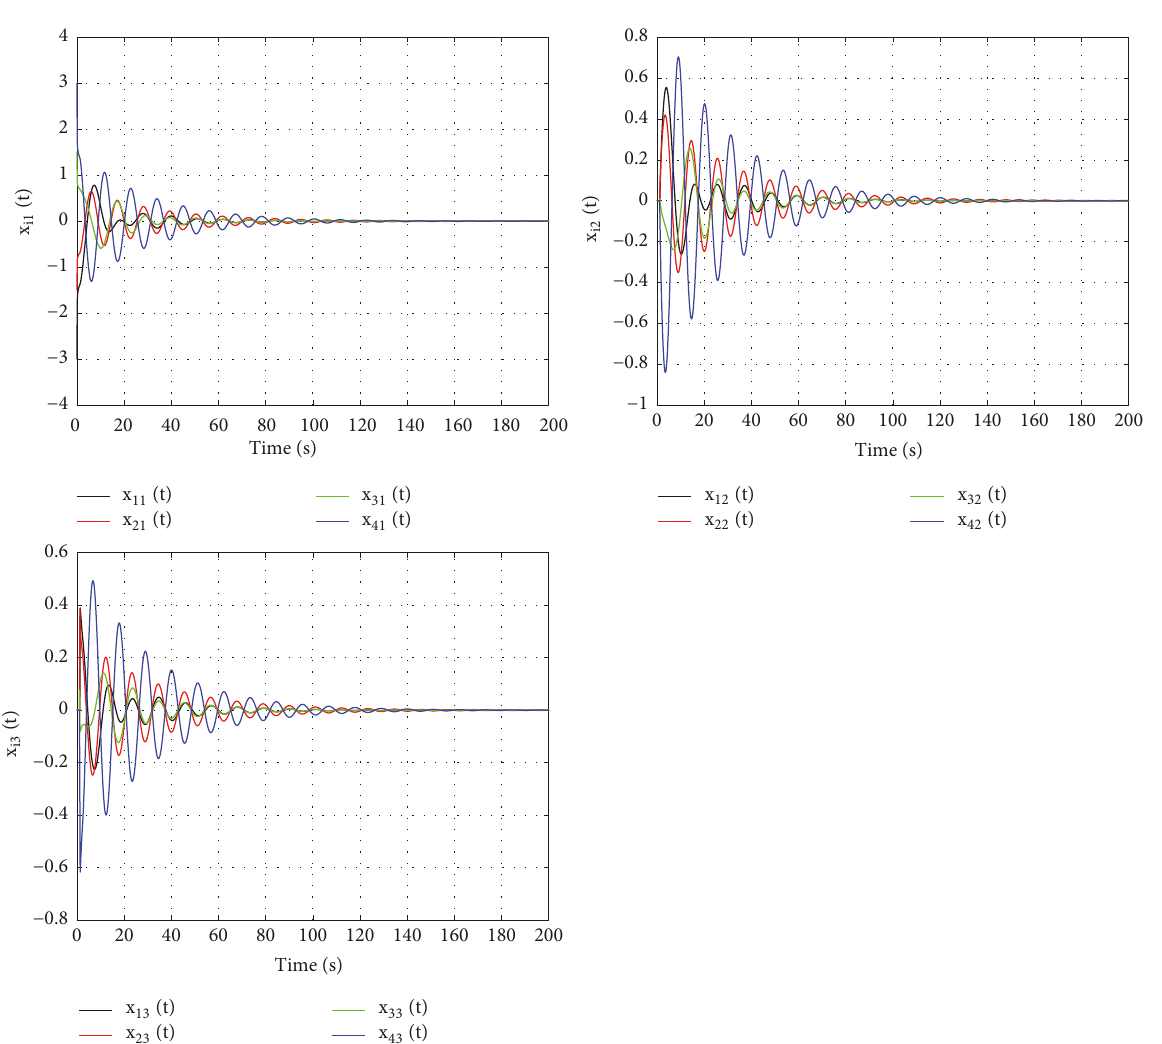
of the FOMAS with double integral and symmetric